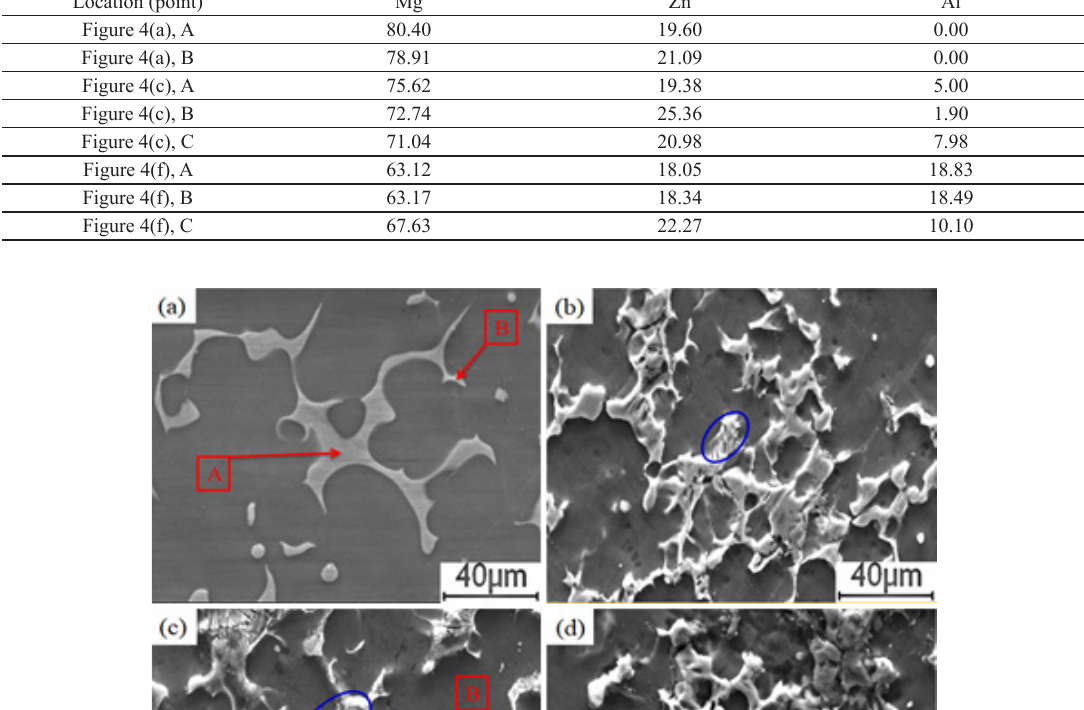
Table 2. EDS results of the as-cast alloys (at.%) Location